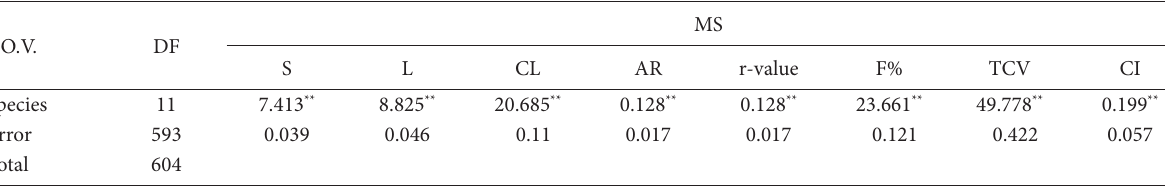
Table 2. ANOVA for chromosomal parameters of berry species.